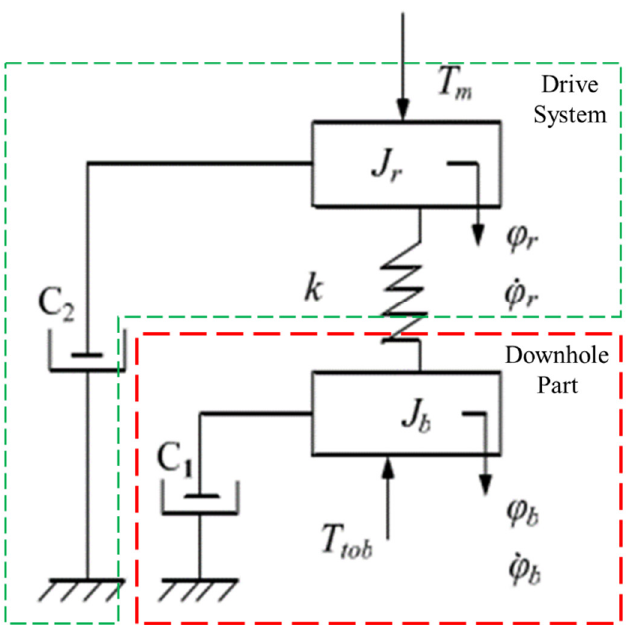
Figure 1. Simplified model of rotation system of drilling rig (model of drive system is in the green box, and that of the downhole part is in the red box).